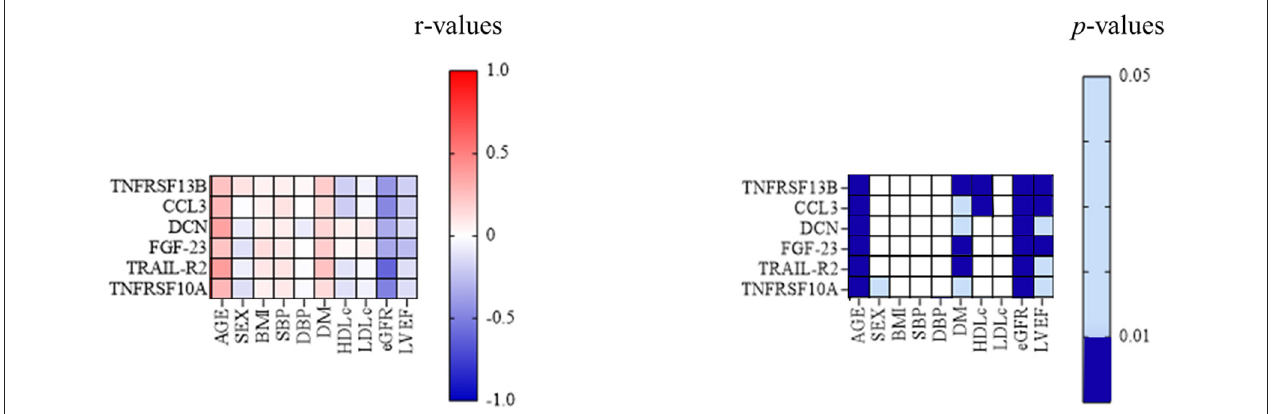
FIGURE 2 | Associations between classic cardiovascular risk factors and inflammatory biomarkers. The correlation between TNFRSF13B, CCL3, DCN, FGF-23, TRAIL-R2, and TNFRSF10A, and the classic cardiovascular risk factors; p -value 0.01–0.05—light blue; p < 0.01—dark blue. BMI, body mass index; CCL3, C-C motif chemokine 3; DCN, decorin; DBP, diastolic blood pressure; DM, diabetes mellitus; eGFR, estimated glomerular filtration rate; FGF-23, fibroblast growth factor 23; HDLc, high-density lipoprotein cholesterol; LDLc, low-density lipoprotein cholesterol; LVEF, left ventricular ejection fraction; MACE, major adverse cardiovascular events; SBP, systolic blood pressure; TNFRSF10A, tumor necrosis factor receptor superfamily member 10A; TNFRSF 13B, tumor necrosis factor receptor superfamily member 13B; TRAIL-R2, tumor necrosis factor-related apoptosis-inducing ligand receptor 2.